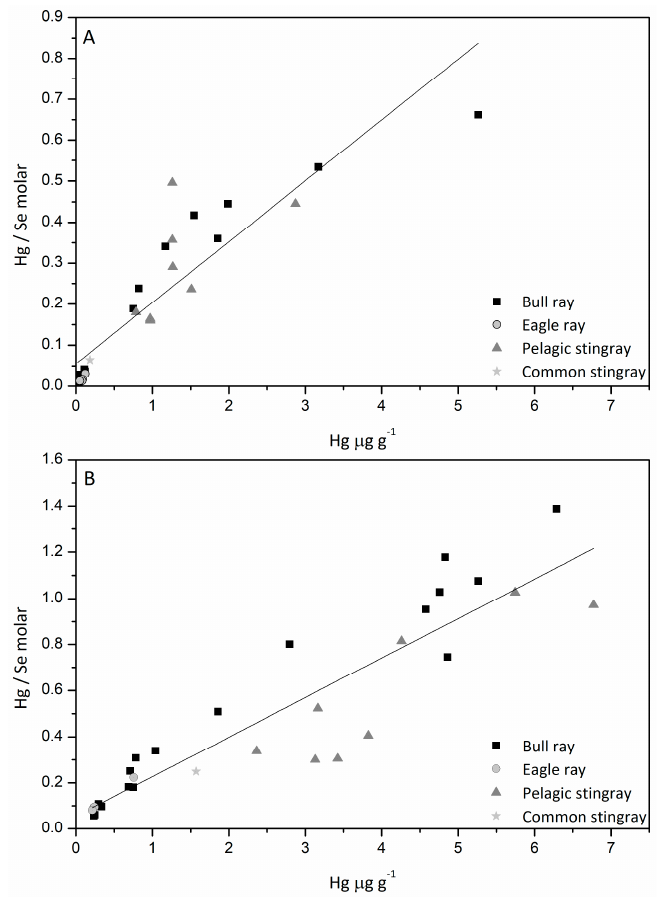
Figure 4. Relationship between Hg/Se ratios (molar) and Hg contents in liver ( A ) Hg/Se = 0.15Hg + 0.05 ( r 2 = 0.82, n = 29), and muscle ( B ) Hg/Se = 0.17Hg + 0.06 ( r 2 = 0.84, n = 30) of rays.